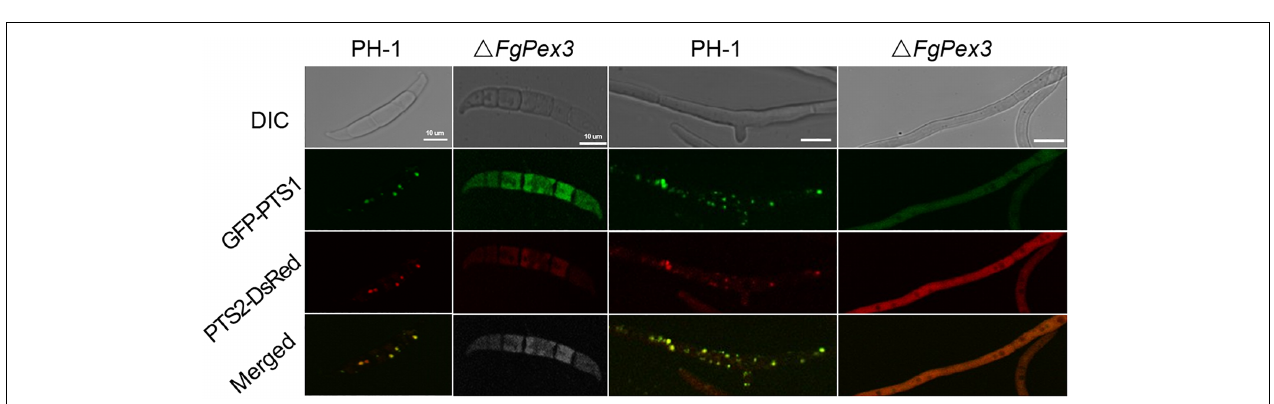
FIGURE 3 | Peroxisomal targeting fusion proteins in spores (left) and mycelia (right) of PH-1 and (cid:49) FgPex3 . The fluorescence of GFP-PTS1 and PTS2-DsRed localized to peroxisomes as discernable structures in the wild type strain PH-1, whereas both types of fluorescence exhibited a diffuse pattern in the cytoplasm of the mutant (cid:49) FgPex3 . DIC, differential interference contrast; GFP-PTS1, green fluorescent protein contained in the peroxisomal targeting signal 1; DsRed-PTS2, red fluorescent protein contained in the peroxisomal targeting signal 2; Merge, overlays of green and red fluorescence proteins images. Scale bar = 10 µ